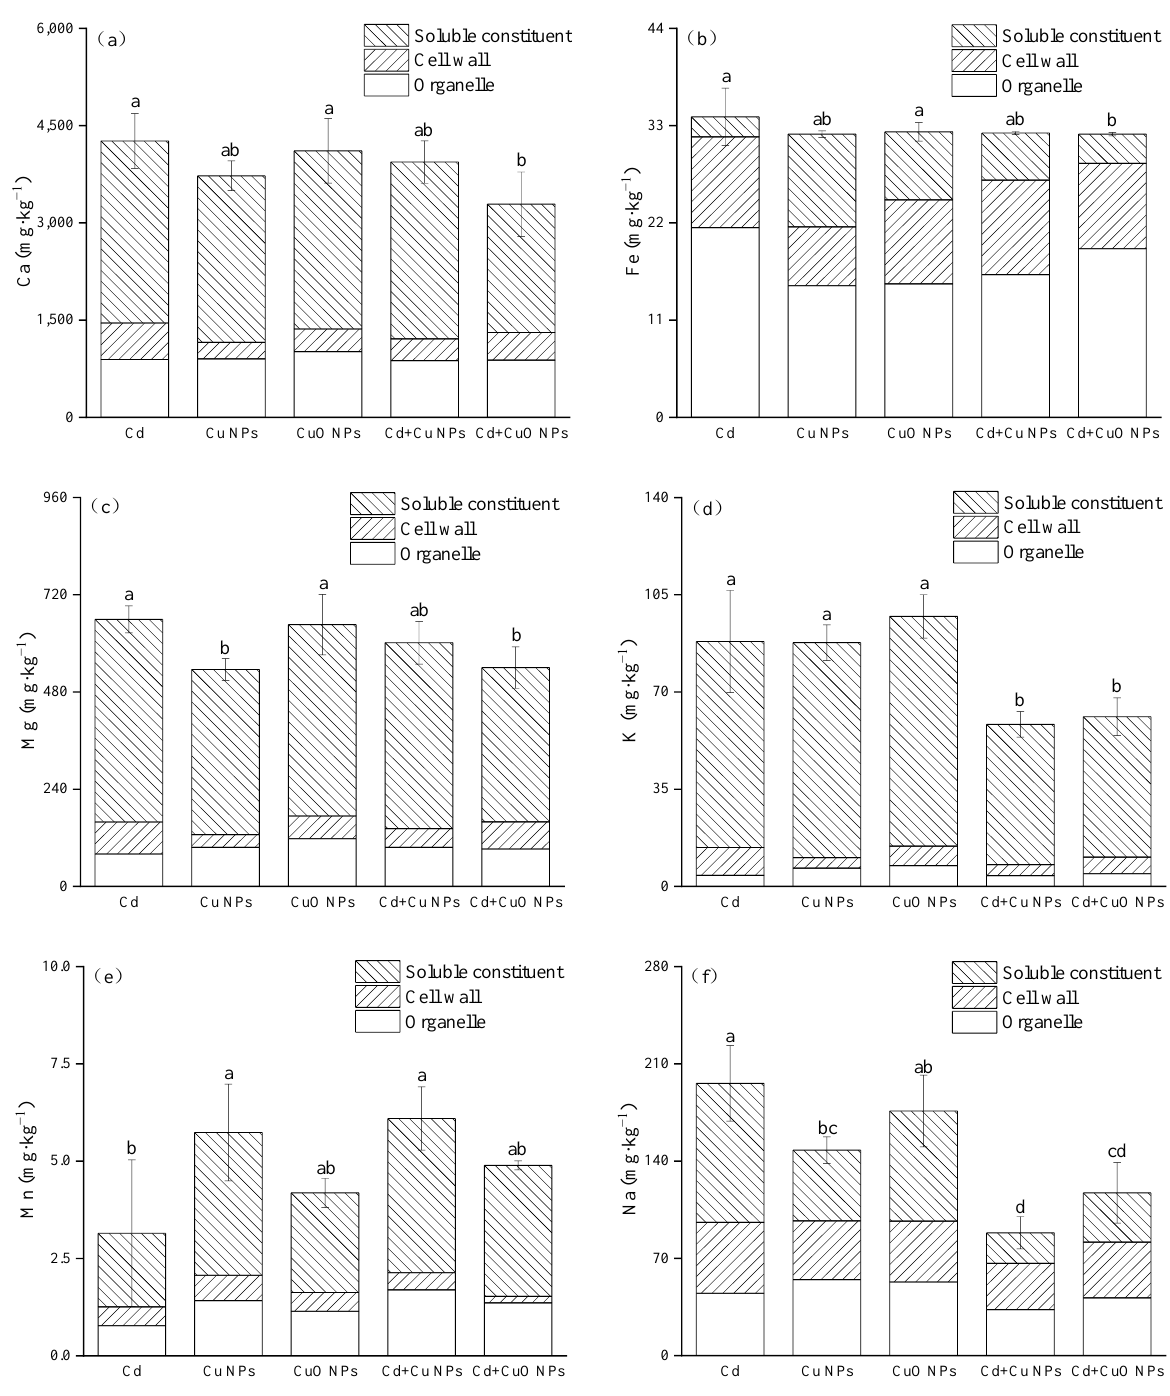
Figure 4. Effects of Cu NPs, CuO NPs and Cd on the subcellular contents of Ca ( a ), Fe ( b ), Mg ( c ), K ( d ), Mn ( e ) and Na ( f ). The mean is the mean of three replicates and the error bars correspond to the standard deviation of the three values. Different letters above each column indicate significant differences between treatments in the same group ( p < 0.05).